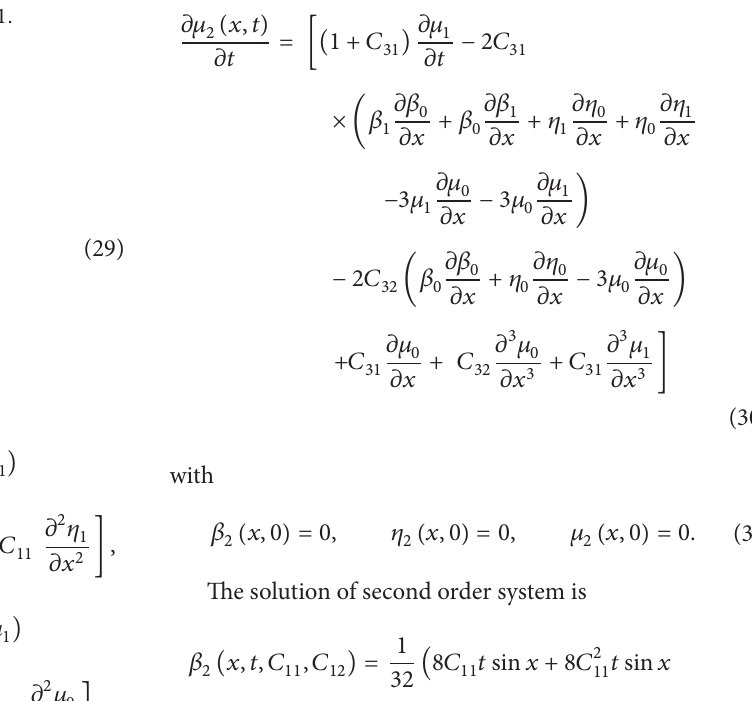
Figure 9: 3D, residual of 𝜇(𝑥, 𝑡) at 𝑡 = 0.1 .